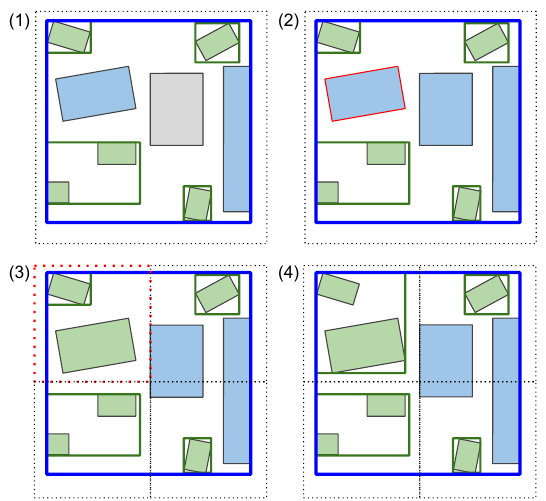
Figure 5: Adding procedure. (1) Feature to add (in grey). (2) Find lowest weight feature (red border) of current tile. (3) Remove lowest weight feature from child tile and add it to the child tile in which it lies (red dashed border). (4) Recompute bounding boxes.